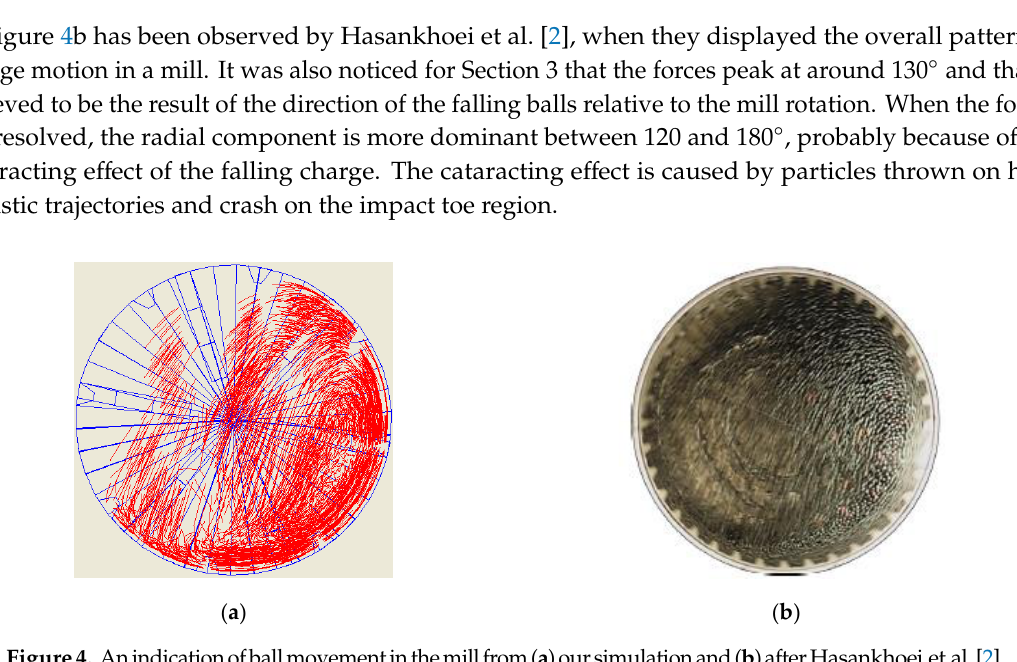
Figure4. Anindicationofballmovementinthemillfrom( a )oursimulationand( b )afterHasankhoei et al.[2]. Figure 4. An indication of ball movement in the mill from ( a ) our simulation and ( b ) after Hasankhoei et al. [2].